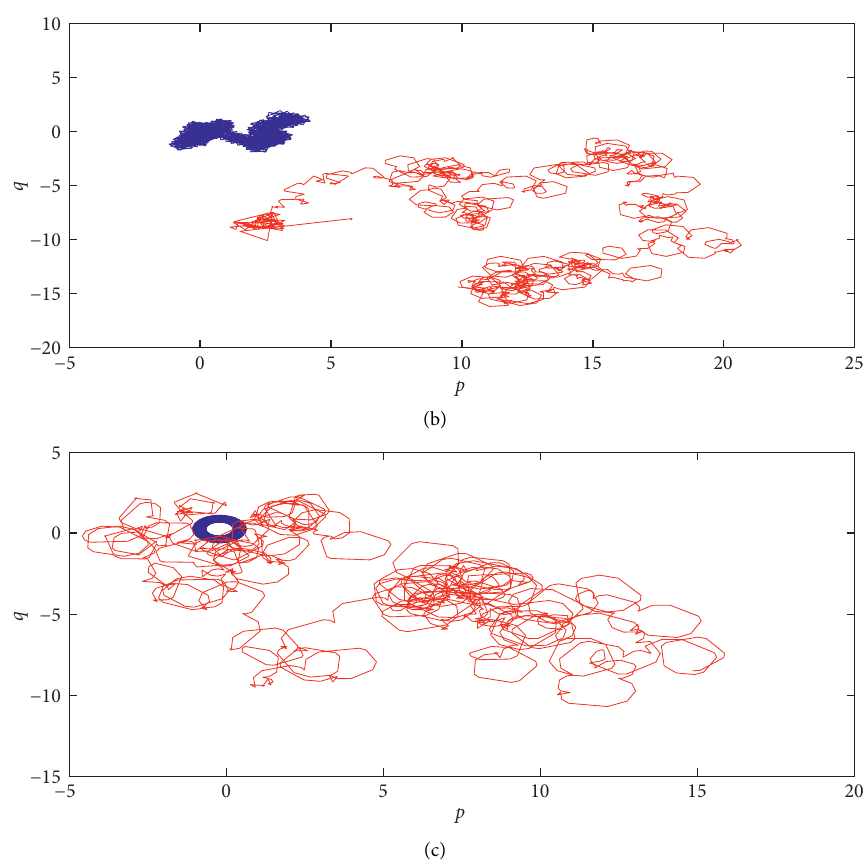
Figure 10: 0-1 test of the fractional map (8) for system parameters A � 0 . 5 , B � 0 and C � 3: (a) Brownian-like trajectories for μ � 0 . 9; (b) Brownian-like trajectories for μ � 0 . 6 and for two different initial condition (red color for x like trajectories for μ � 0 . 3 and initial condition x